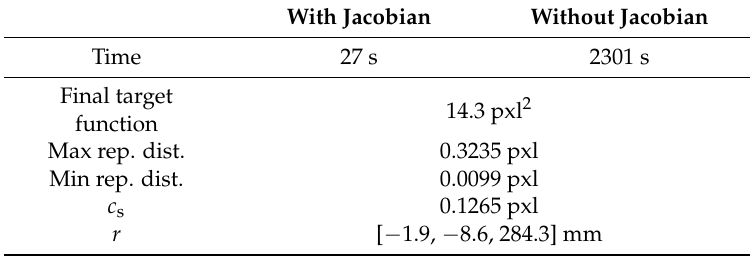
Table 1. Comparison of the optimization process performances with or without the Jacobian matrix. With